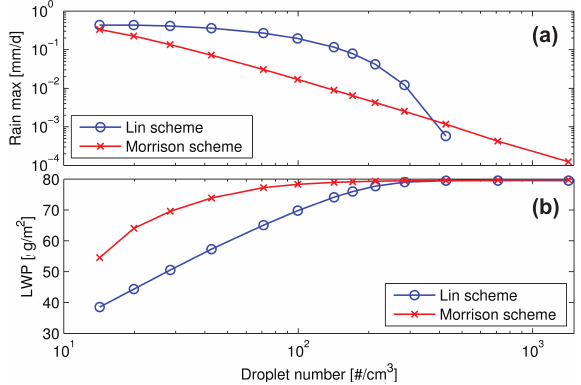
Fig. 11. Results from column study for comparing Lin and Mor- rison microphysics schemes for a profile on (80 ◦ W, 20 ◦ S) at 00:00UTC on 28 October 2008. (a) shows maximum rain rate per profile while (b) shows liquid water path (LWP) per profile. Each profile is run with a different droplet number concentration using a 12s time step for enough time to reach stable conditions. For (a) , missing points means rain rate equal to